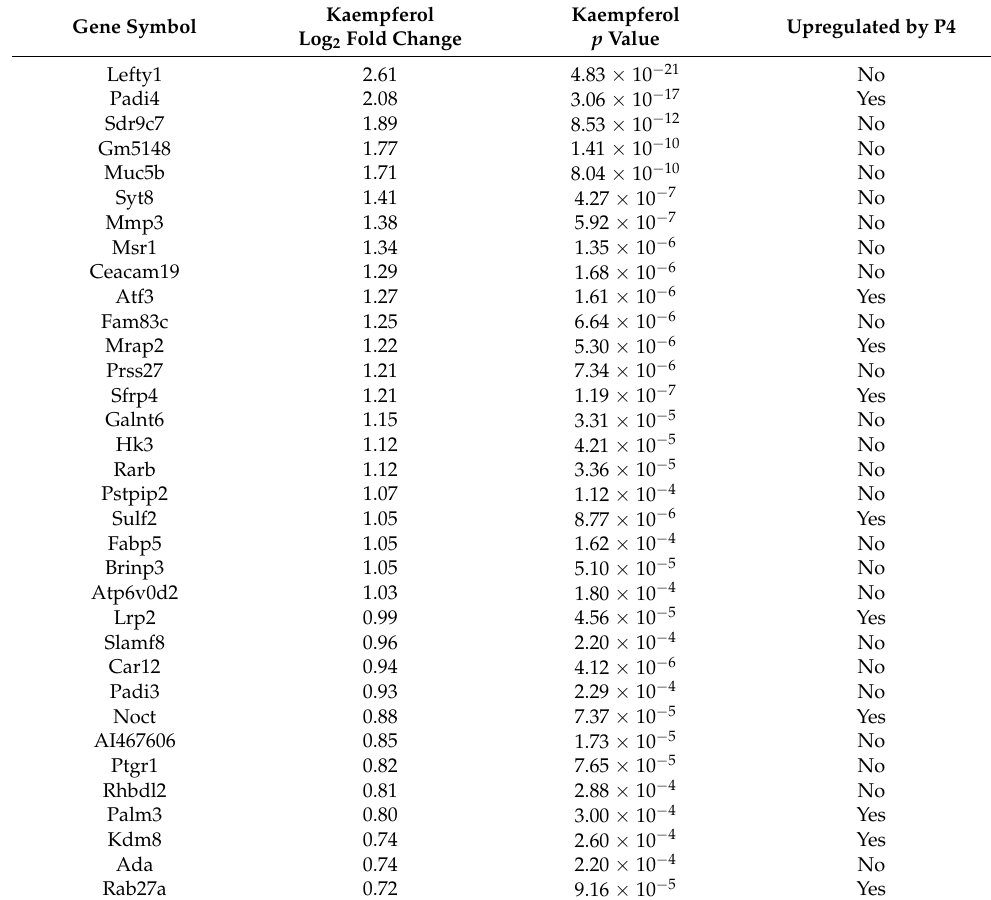
Figure 5. ( A ) Significantly upregulated genes found in RNAseq of P4 and kaempferol-treated uterine tissue. ( B ) Significantly downregulated genes found in RNAseq of P4 and kaempferol-treated uterine tissue. ( C ) Similarly regulated GSEA pathways between P4 and kaempferol treatments. Table 1. Transcripts significantly upregulated by kaempferol treatment when compared with vehicle-treated tissue.